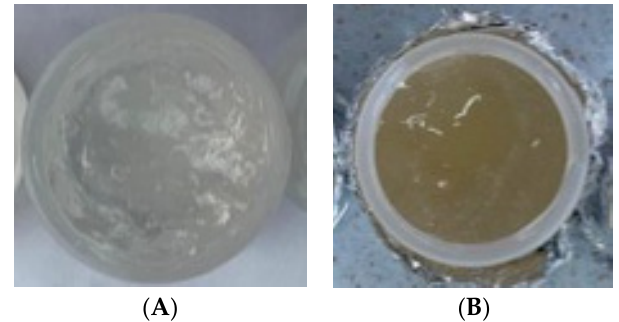
Figure 8. (A) NTC gel preparation; ( B ) TC gel preparation. Figure 8. ( A ) NTC gel preparation; ( B ) TC gel